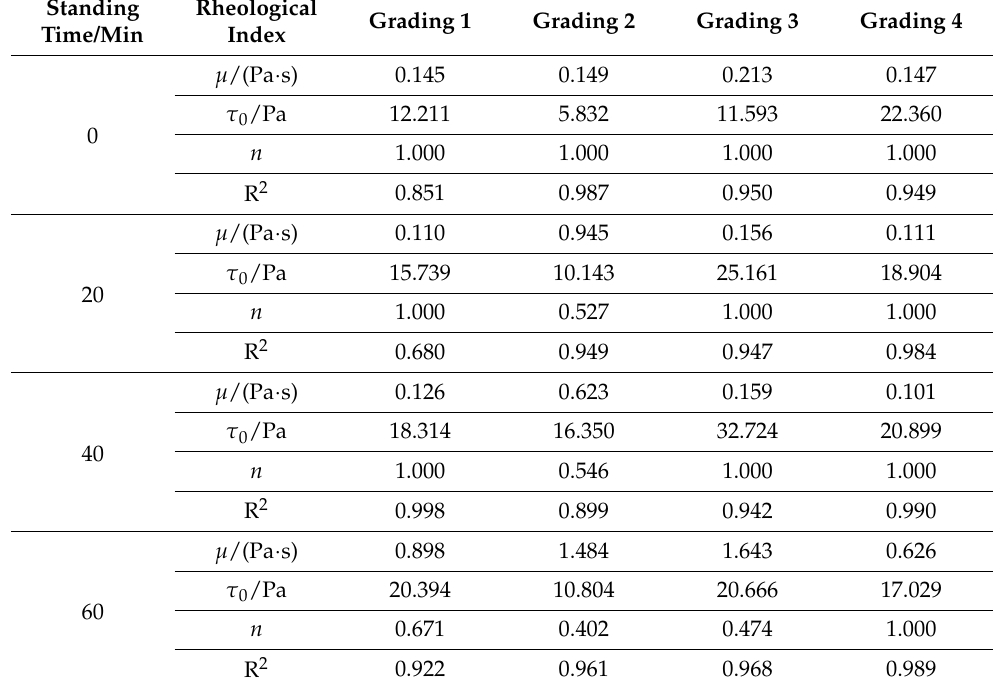
Table 4. Rheological parameters of filling paste at 65% mass fraction.